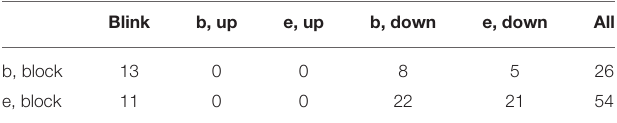
TABLE 9 | Emblem/block—frequency of items from the gaze class.